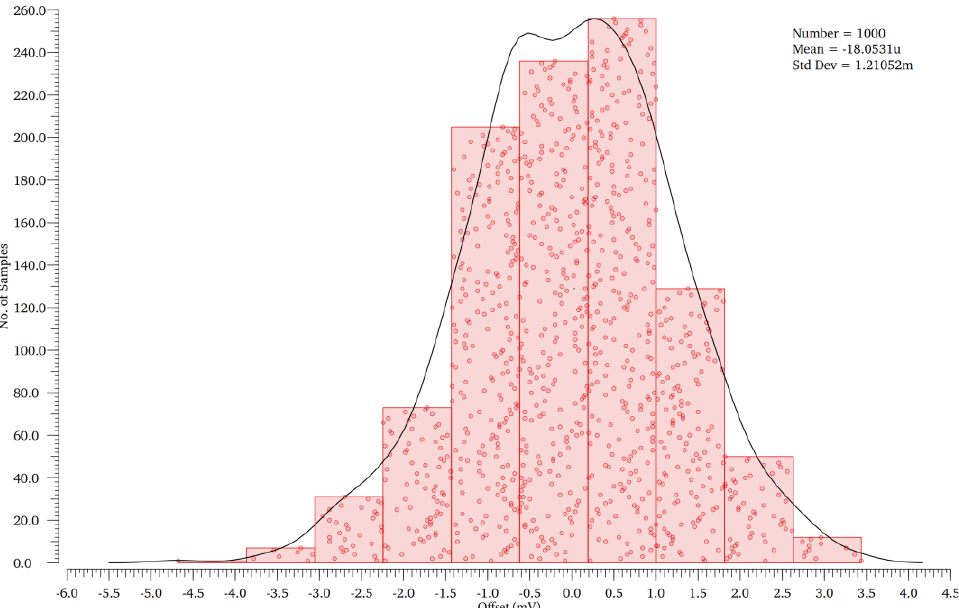
Figure 13. Monte Carlo simulation of the offset voltage for 1000 points.